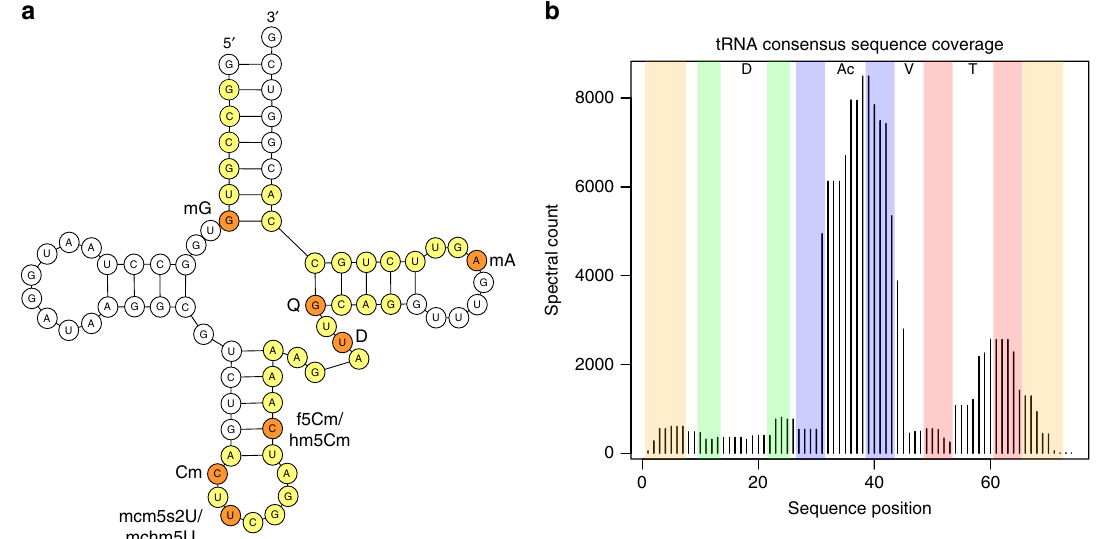
Fig. 5 Human tRNA analysis results. a A schematic depiction of Homo sapiens tRNA-Arg TCG , showing identi fi ed sequences that map uniquely to this isoacceptor (yellow for unmodi fi ed and orange for modi fi ed residues). Total coverage is 52%. Two different modi fi cation variants were observed at U34 (wobble position) and C40. b Aggregated coverage of the consensus tRNA sequence by oligonucleotides identi fi ed in the human tRNA dataset. Some oligonucleotide positions in long tRNAs (tRNA-Leu, tRNA-SeC, tRNA-Ser) were adjusted to fi t the consensus sequence. Complementary regions in the acceptor stem (orange), D-stem (green), anticodon stem (blue) and T-stem (red) are highlighted. D D-loop, Ac anticodon loop, V variable region, T T-loop.